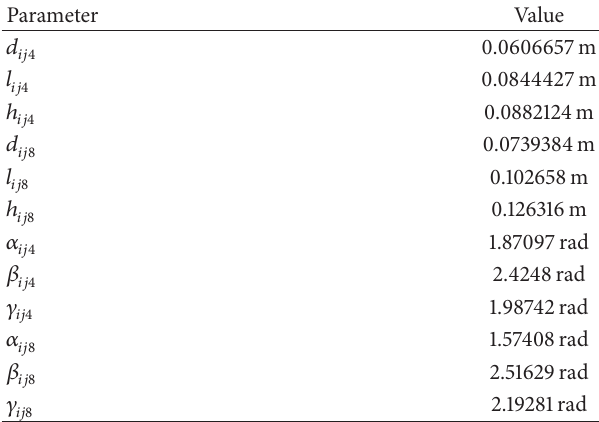
Table 2: Kinematic parameters of the Theo Jansen linkage mecha- nism.